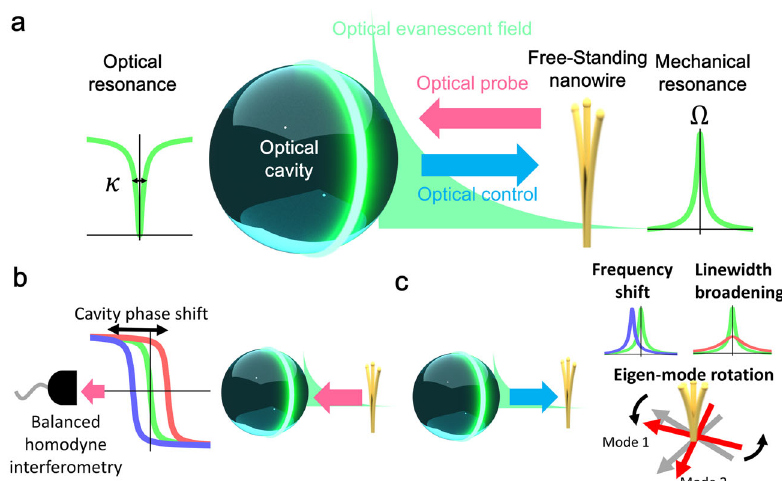
Fig. 1 Conceptual illustration of near- fi eld cavity optomechanics with a free-standing nanowire and a whispering-gallery mode microsphere. a Near- fi eld cavity optomechanical coupling between the nanowire and microsphere via an optical evanescent fi eld. Ω and κ denote the mechanical frequency and optical linewidth, respectively. b Optical probe of mechanical displacement via cavity phase modulation with balanced homodyne interferometry. c Optical control of mechanical response with frequency shifts, linewidth broadening, and eigen-mode rotation via static optical force.